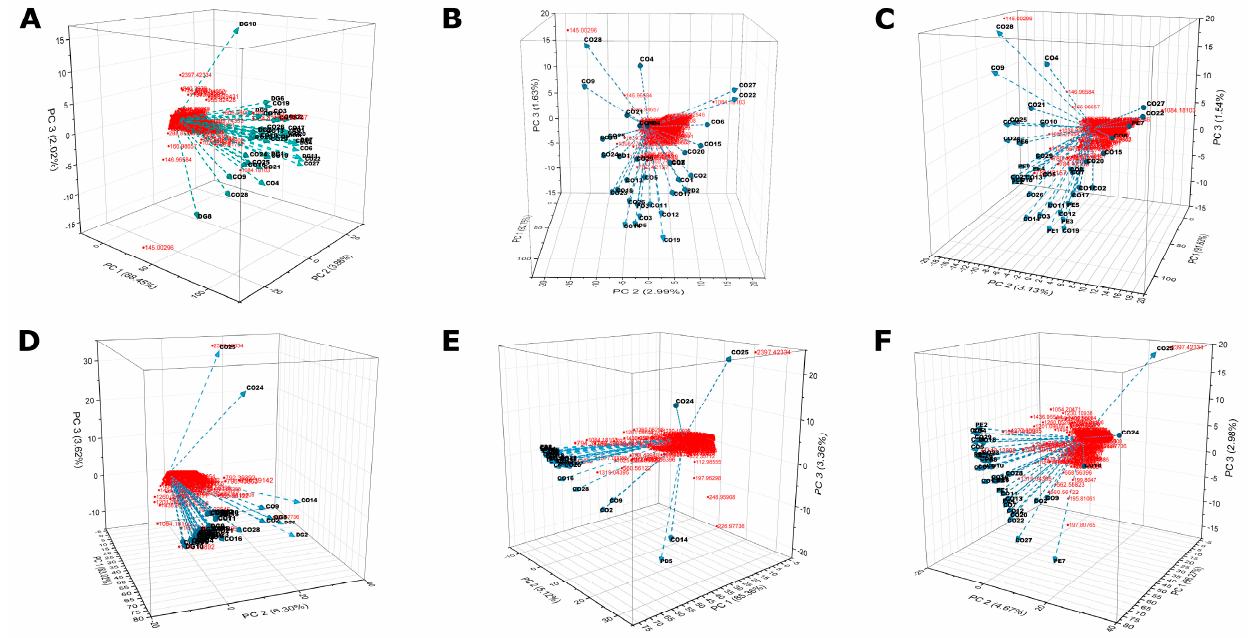
Figure 6. Analysis of metabolites in fecal samples by FT-ICR MS. Metabolites extracted from fecal samples were analyzed using a Fourier Transform Ion Cyclotron Resonance Mass Spectrophotometer (Solarix XR Bruker) calibrated in positive mode for CO versus GD ( A ), CO versus PD ( B ), CO versus PE ( C ), and negative mode for CO versus GD ( D ), CO versus PD ( E ), and CO versus PE ( F ) see Materials and Methods. For each graphic, the PC1, PC2, and PC3 axes indicate the PCA ordination as a percentage of the total variance explained. The red color is the m/z values and the lines with conic tips represent the samples that are identified by